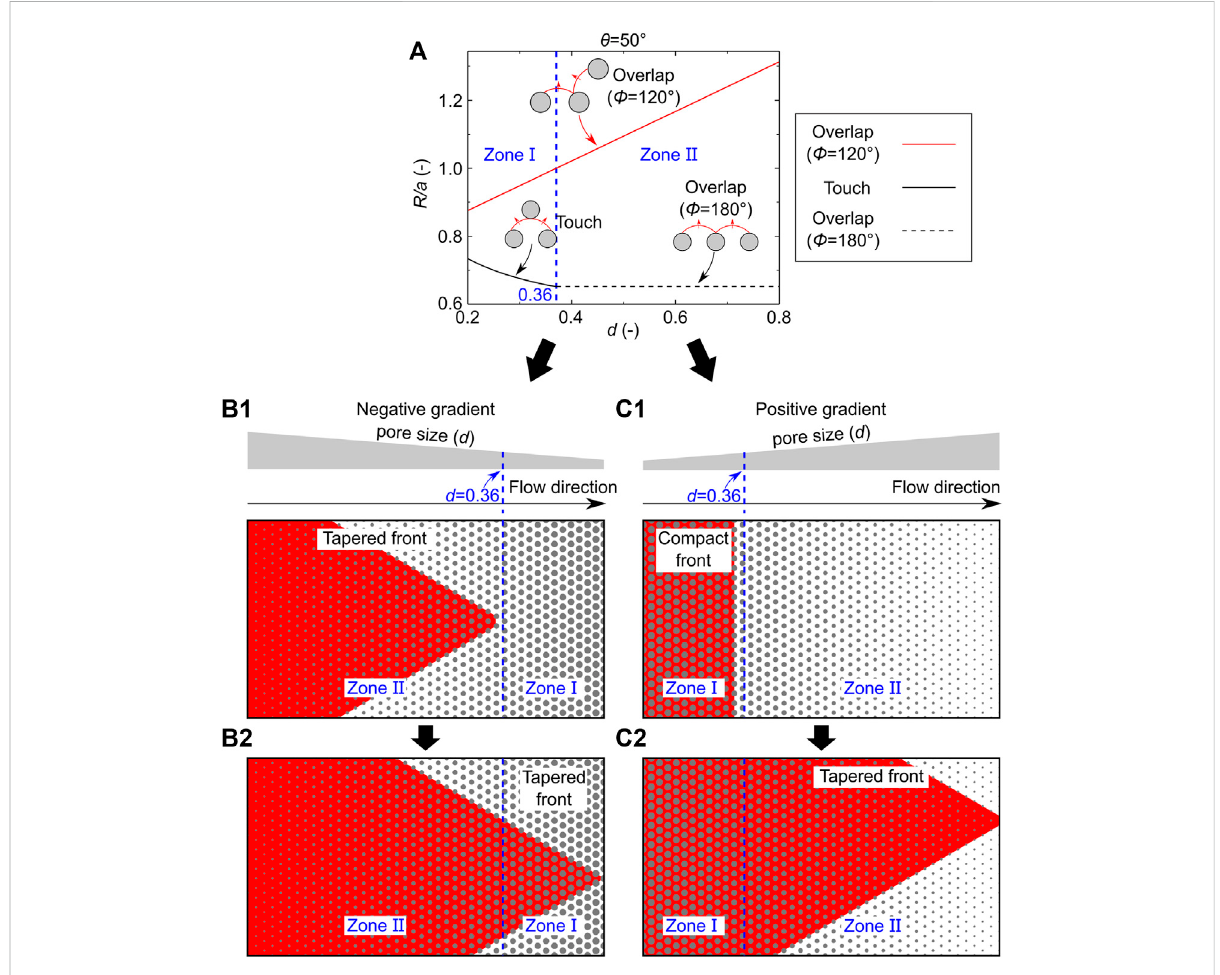
FIGURE 4 Linking pore- fi lling events to local invasion morphologies at θ = 50 ° . (A) Critical radius of curvature of pore- fi lling events varies with pore size. The red line represents the overlap event with Φ = 120 ° , and the black solid and dashed line represent the touch event and overlap event ( Φ = 180 ° ), respectively. The overlap event with Φ = 120 ° and the touch event occurs in zone Ⅰ (0.2 ≤ d ≤ 0.36), and the overlap events with Φ = 120 ° and 180 ° occurinzone Ⅱ (0.36 < d ≤ 0.8). (B) Innegativegradientporousmedia, theinvadingphaseinvadesfromzone Ⅱ tozone Ⅰ .Theoverlapeventwith Φ = 120 ° dominates the fl uid invasion, leading to a tapered front in both zones Ⅰ and Ⅱ . (C) In positive gradient porous media, the invading phase invadesfromzone Ⅰ tozone Ⅱ . (C1) Inthebeginning,acompactfrontisobtained. (C2) Aftertheinvadingphasereacheszone Ⅱ ,theoverlapevent( Φ = 120 ° ) leads to a tapered